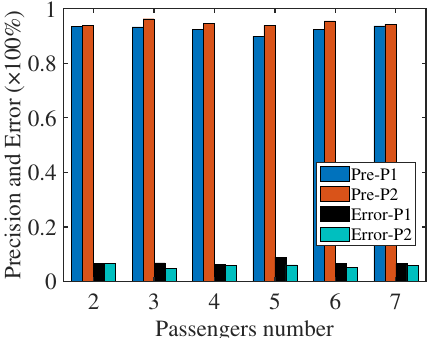
Figure 13. Precision and estimation error comparison.